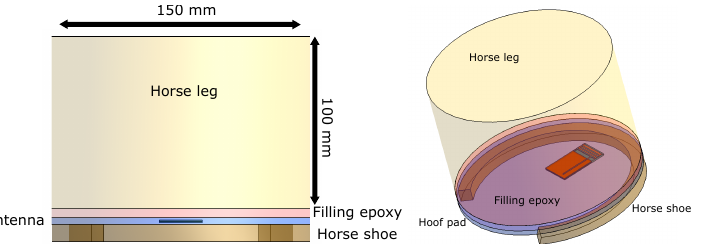
Figure 2. The model setup consisting of the horse leg, the hoof pad with the embedded antenna, the filling epoxy, and the horseshoe. Horseshoe = 10 mm, Pad+antenna = 4 mm, Filling epoxy = 5 mm. The parameters of interest are the reflection coefficient, − 10 dB bandwidth